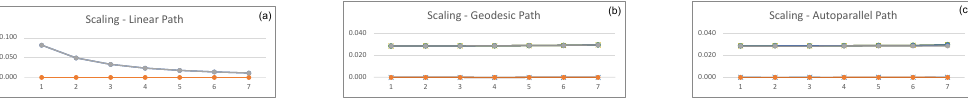
Figure 3. Trend of the energies for different interpolations: ( a ) Left: linear interpolation ( b ) Center: geodesics interpolation. ( c ) Right: autoparallel interpolation. Blue refers to d u , red to d b , grey to d tot . Table 1. Values of the energies for the affine spherical case; d u represents the affine component of the Γ -energy, d Γ b the non-affine component and d tot the total